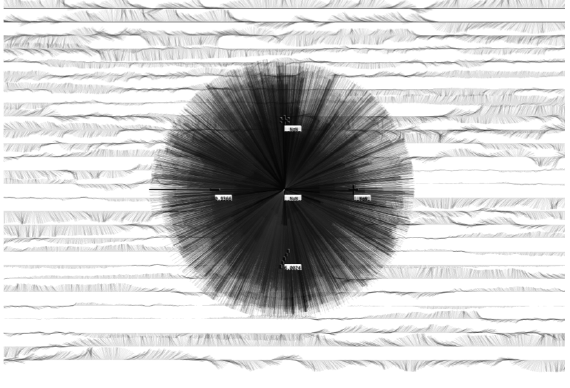
FIGURE 5 | André Sier, 32-bit Wind Machine (2011). Computer, projector, wind sensor. Courtesy André